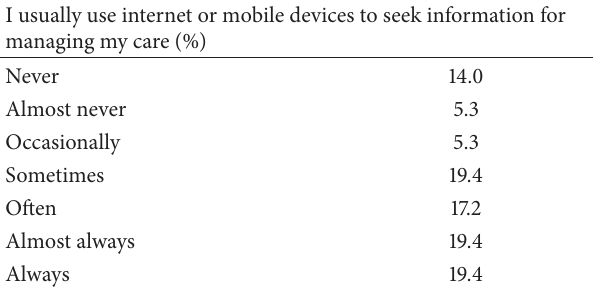
Table 2: Frequency of mHealth/eHealth